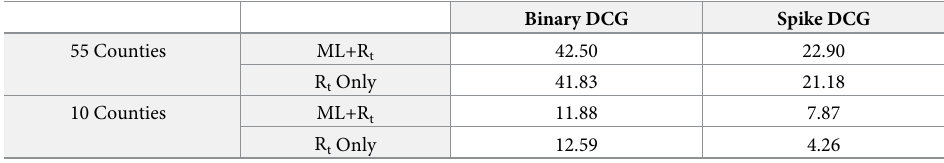
Table 1. A comparison of total both DCG metrics for recommendations of 10 counties and 55 counties for the ML+R t methods